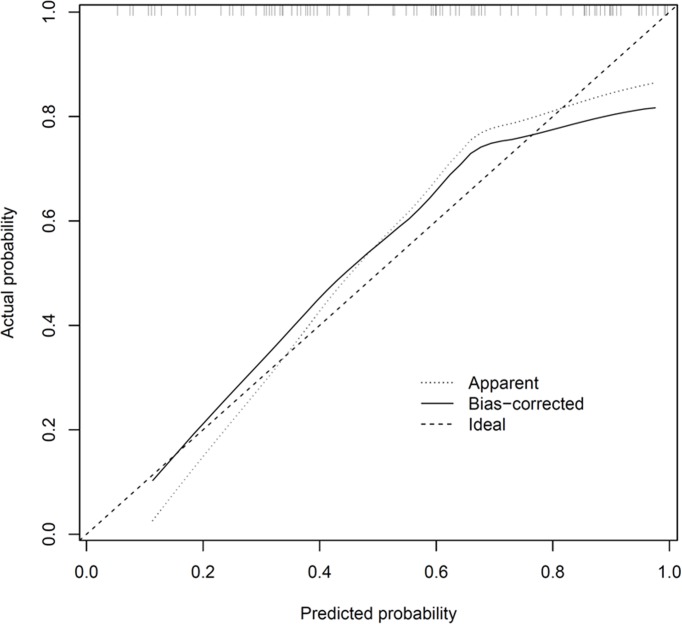
Calibration plot which illustrates the accuracy of the original prediction model (“Apparent”) and the bootstrap model (“Bias-corrected”) in predicting the probability of requiring a quadstick or walking frame.Perfect calibration accuracy is represented by the “ideal” line of unity. Locally weighted scatterplot smoothing is used to model the relationship between observed and predicted probabilities. The distribution of the predicted probabilities is shown as small vertical lines at the top of the graph.